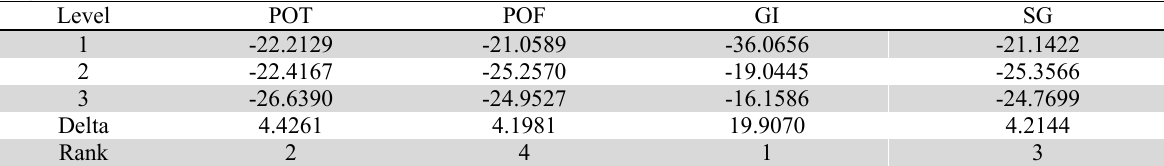
Signal to Noise (S/N) Ratio for